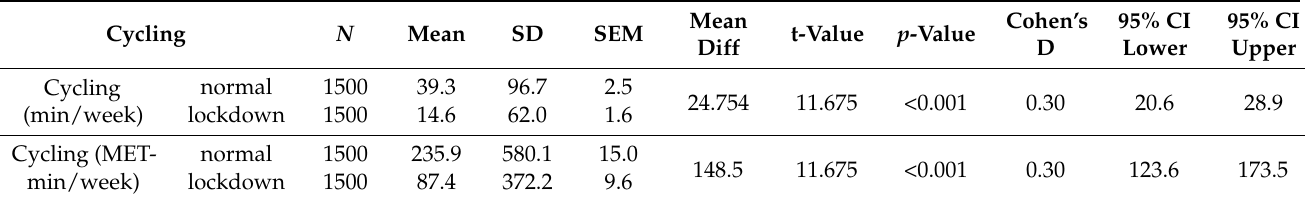
Table 5. Cycling minutes per week and cycling MET-minutes per week.